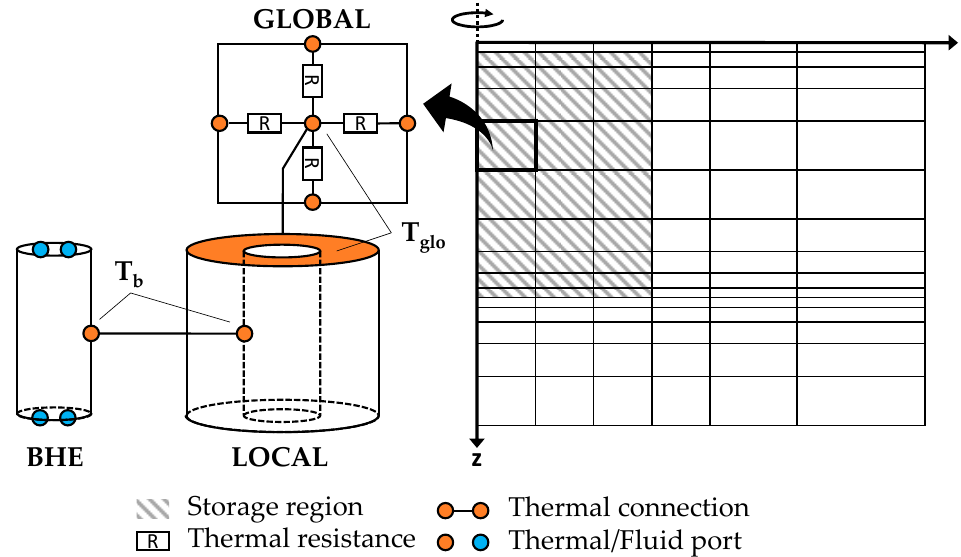
Figure 1. Mesh of a MoBTES model ( right ) and the fundamental connection scheme of the sub-models ( left ). The local element interconnects the global elements to their associated borehole heat exchanger (BHE) elements by giving a relation between the borehole wall temperature (T b ) and the mean volume temperature (T glo ).